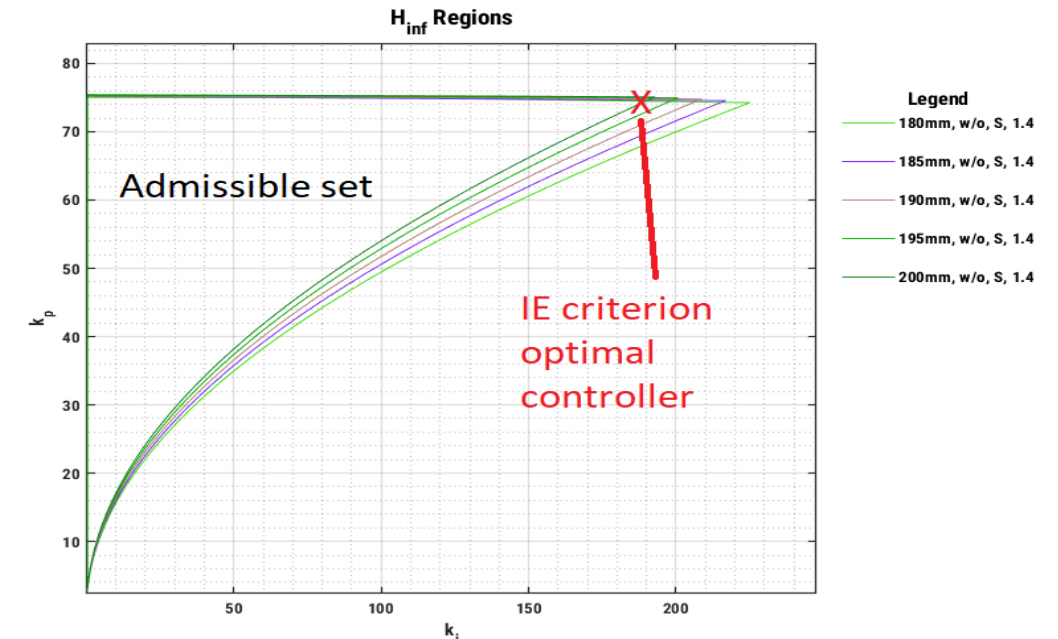
Figure 20. Computed H ∞ regions corresponding to the specified maximum sensitivity and assumed plant models; the intersection of regions defines the admissible set of